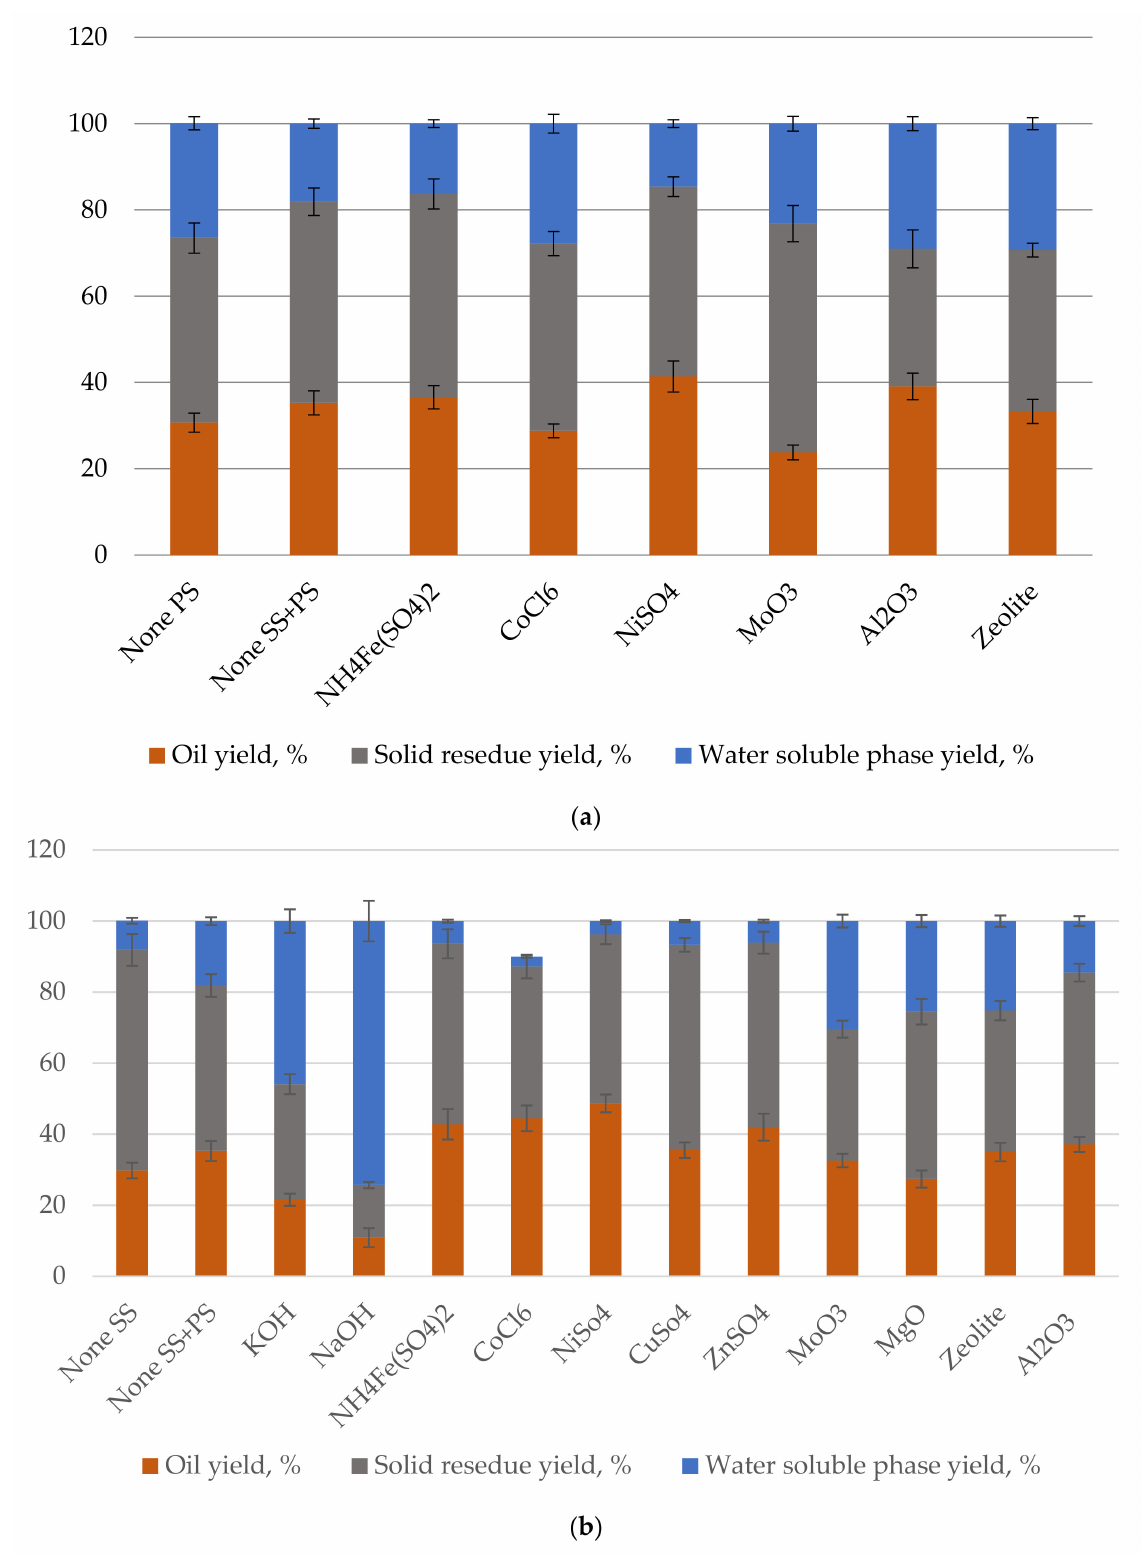
Figure 4. Effect of homogeneous and erogenous catalysis on product yield: ( a )—primary sludge, ( b )—secondary sludge; “none”—experiment without catalyst, red line—oil yield in experiment without